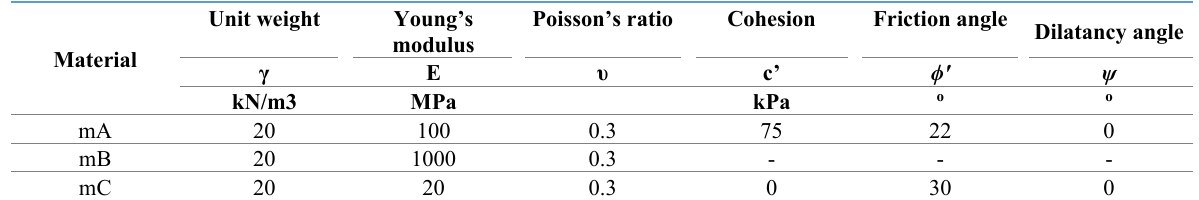
Table 1. Parameters for materials mA, mB and mC.